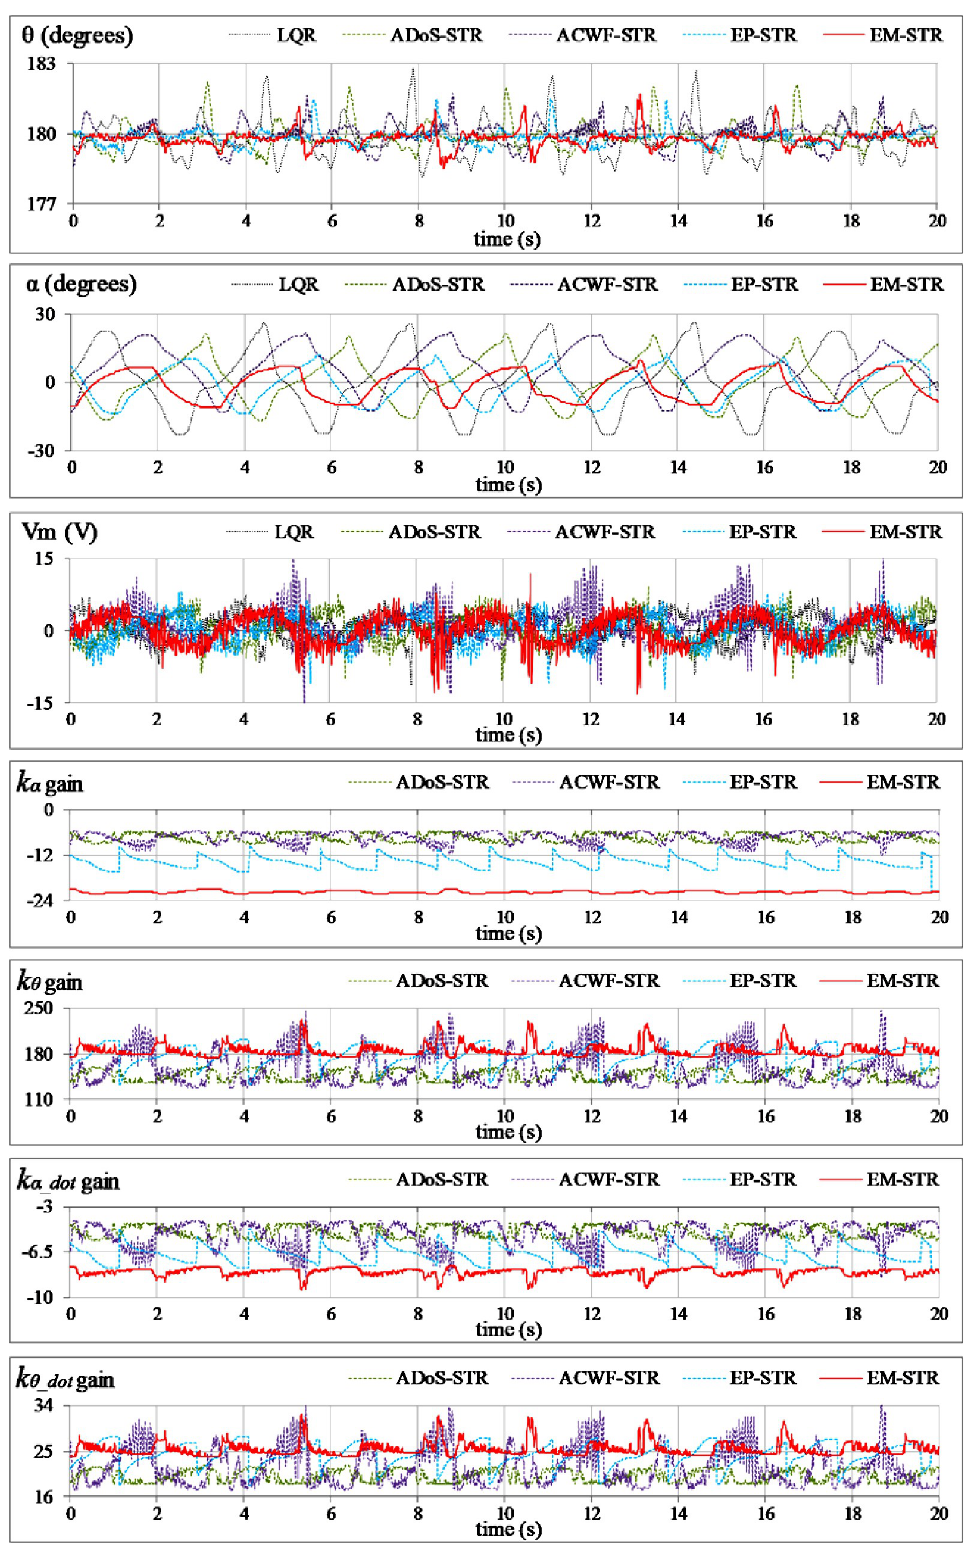
Fig 13. Pendulum’s response under impulsive disturbances.